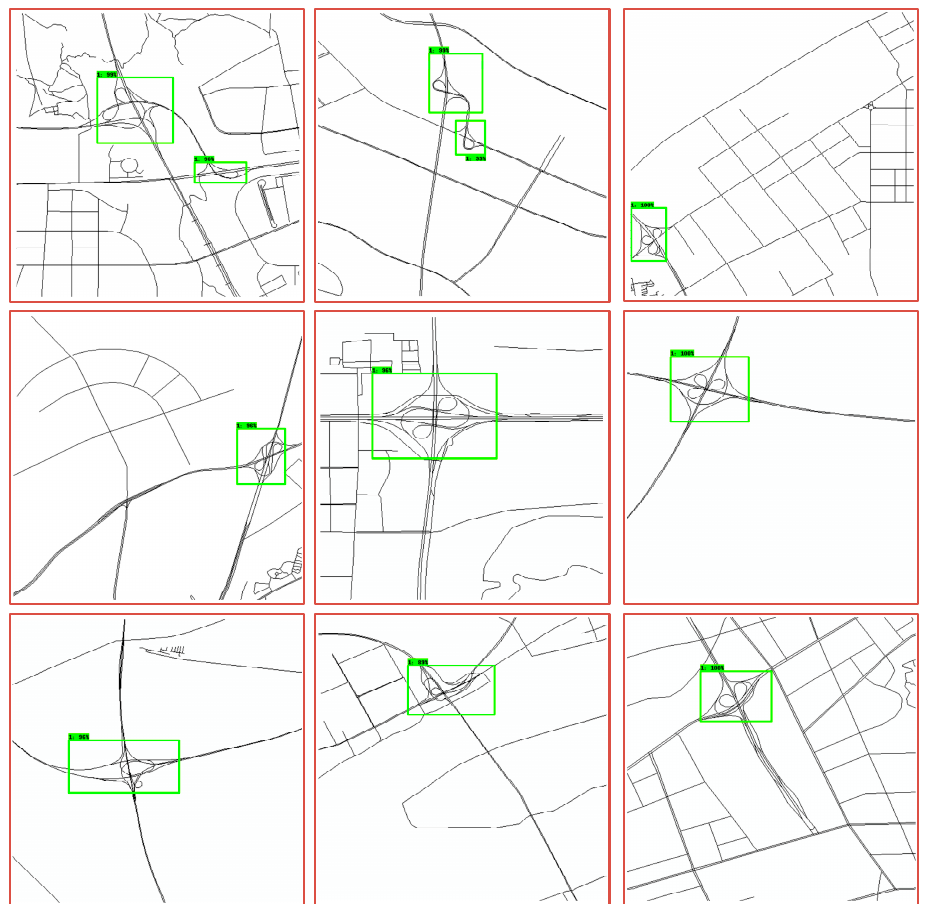
Figure 13. Identification results of overpasses. The range selected in the green box is identified by the model, the value is the probability that the model thinks the range chosen by the green box is the